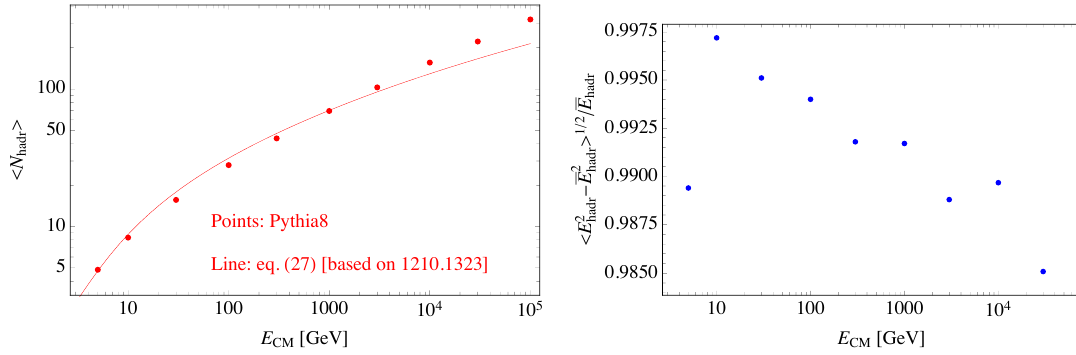
Figure 4 . Left: average hadron multiplicity per single QCD scattering e − e + → q ¯ q . Right: root square mean of the hadron energy per single QCD scattering e − e + → q ¯ q , where ¯ E E / h N hadr i is the average hadron energy per scattering. Dots in both plots are extracted via CM MadAnalysis v1.8.34 [63] by simulations with MadGraph v2.7.0 [64] plus Pythia v8.2 [65], the line in the left-hand plot displays eq. (4.14). Results are expressed as a function of the